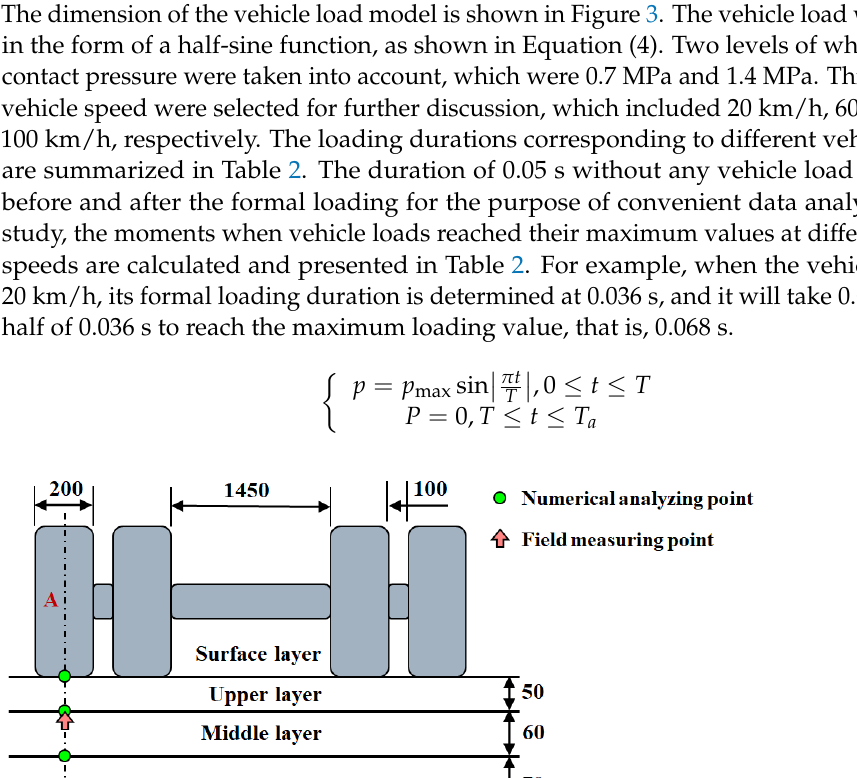
Figure 2. The FEM model of asphalt pavement structure: ( a ) Boundary conditions and load posi- tions; ( b ) Meshing.